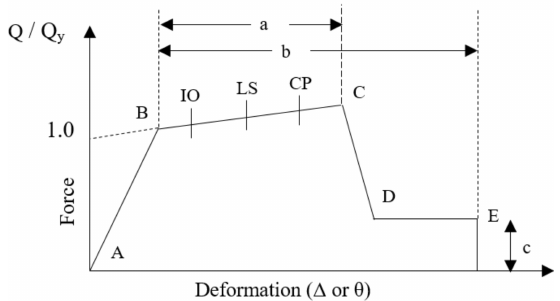
Figure 9. Generalised force deformation curve as per ASCE 41–17